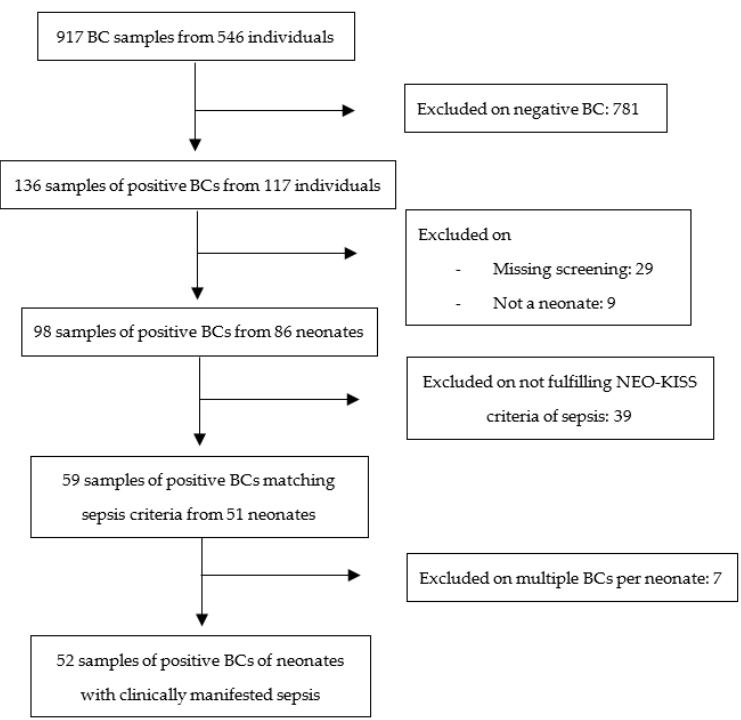
Figure 1. Flowchart and study selection of sepsis patients study arm. Legend: BC = blood culture.